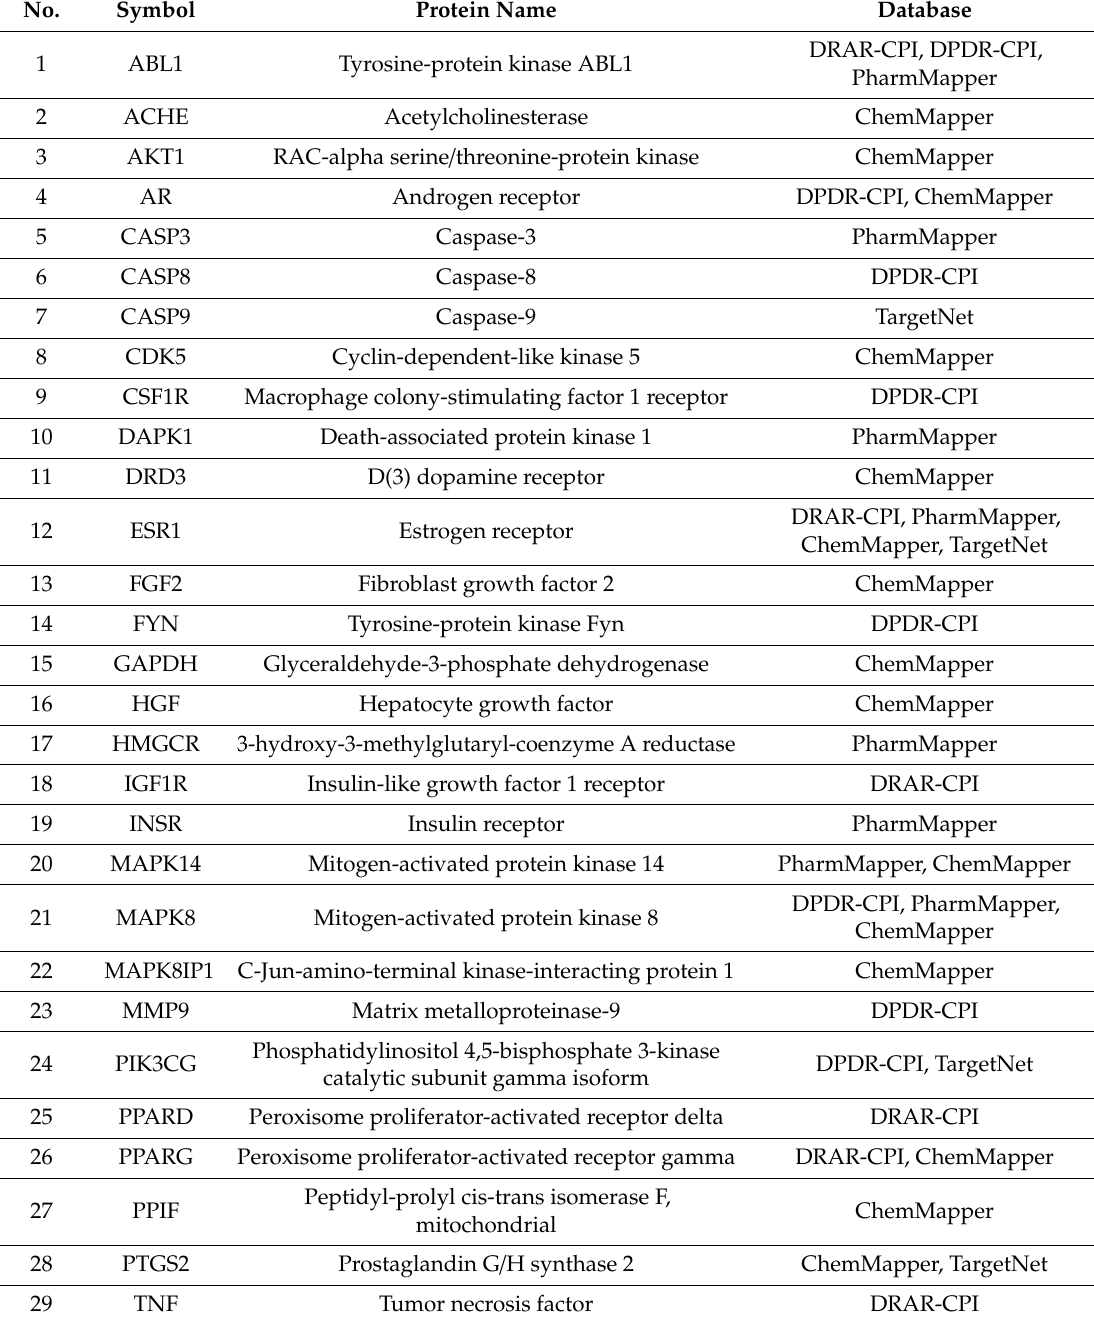
Table 1. Putative therapeutic targets of stemazole mediating its e ff ects against neurodegenerative diseases.